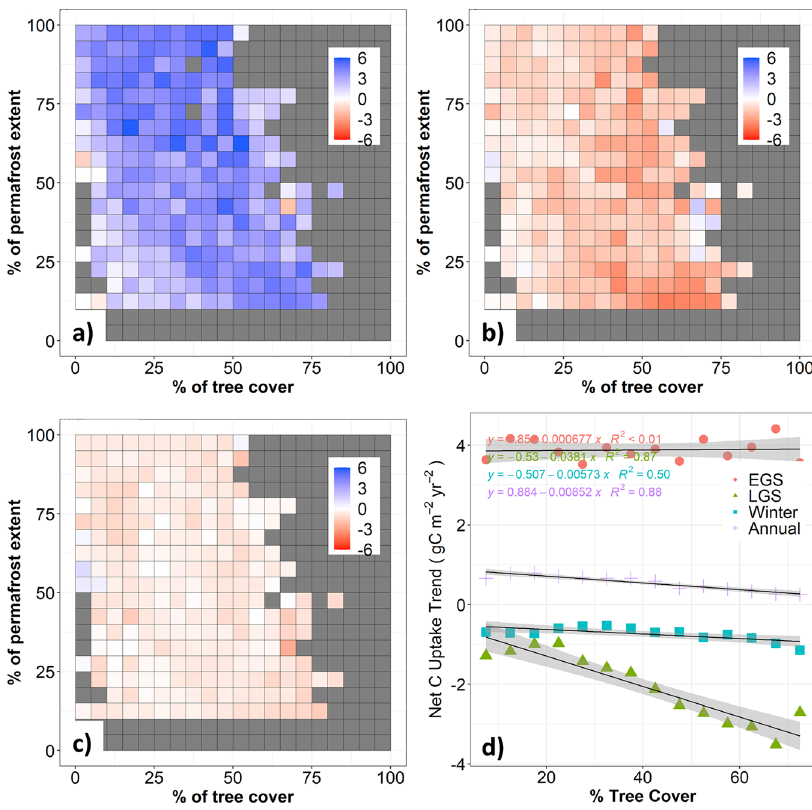
d shows the variation in net CO 2 uptake seasonal trends along the 5% tree cover interval gradient in the NHL. Pixels with grey color represent environmental con- ditions that do not